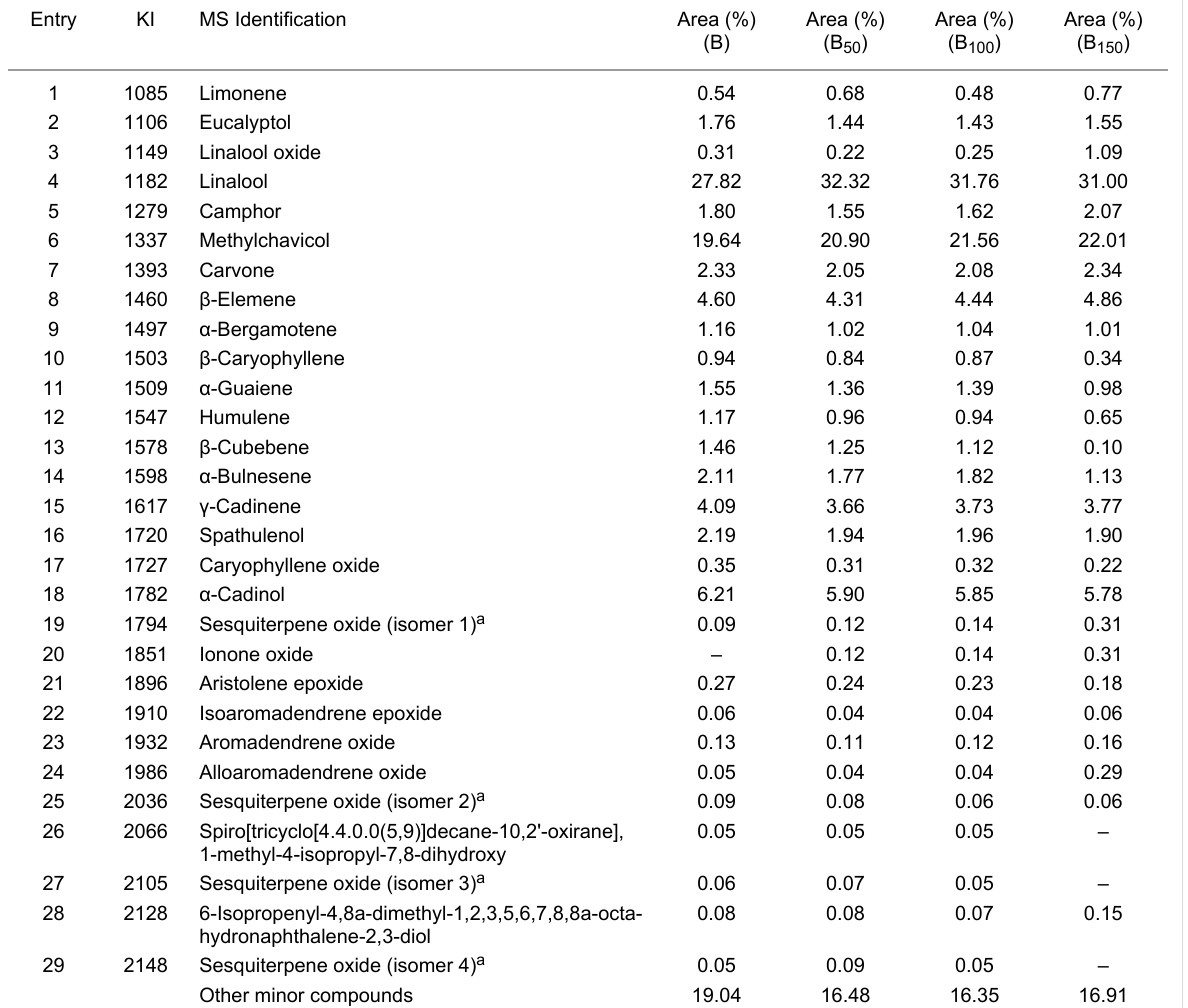
Table 2: The GC–MS data for the non-degraded (B) and thermal/oxidative degraded O. basilicum essential oil at various temperatures (B 50 – degrad- ation temperature of 50 °C, B 100 – 100 °C, B 150 – 150